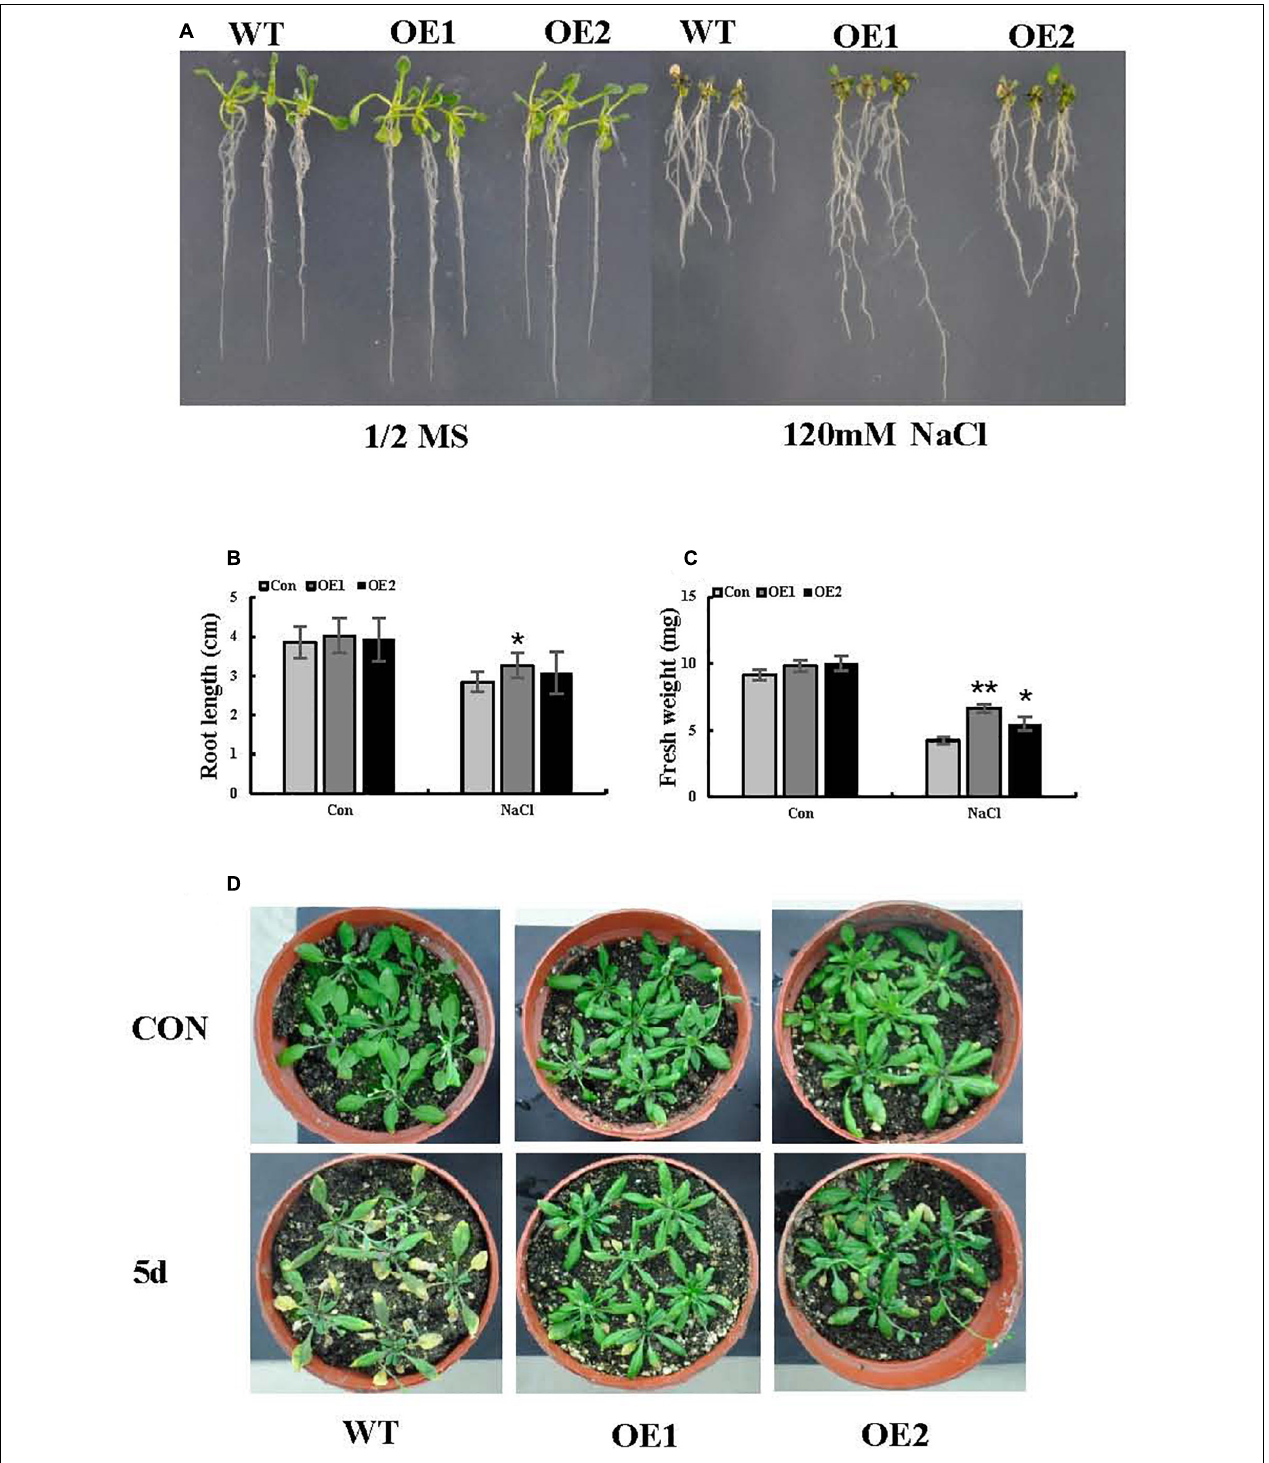
FIGURE 6 | Salt stress tolerance associated with ThSOS3 . (A) Growth comparison between OE and WT plants. Arabidopsis plants grown on 1/2-strength MS medium (control) and 1/2-strength MS medium supplied with 120 mM NaCl were used for growth analysis. (B) Root length and (C) fresh weight were also analyzed in at least 30 seedlings under each treatment. (D) Comparison of growth phenotypes between OE and WT Arabidopsis lines grown in soil. The plants were treated with 150 mM NaCl for 5 days for analysis. Plants grown under normal conditions were used as controls. *Represents a significant difference ( P < 0.05). **Represents a very significant difference ( P <